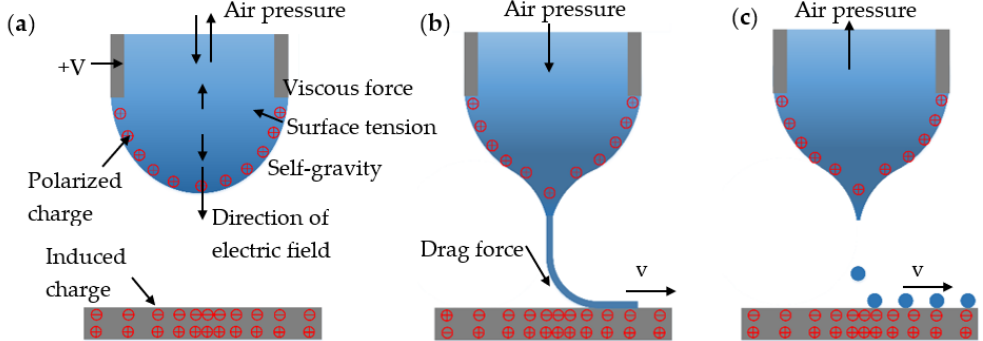
Figure 2. Formation mechanism of the meniscus: ( a ) force analysis of the meniscus and electric field formation; ( b ) high-viscosity material deposition with positive air pressure and drag force form between the cone jet and substrate; ( c ) low-viscosity material with negative air pressure.